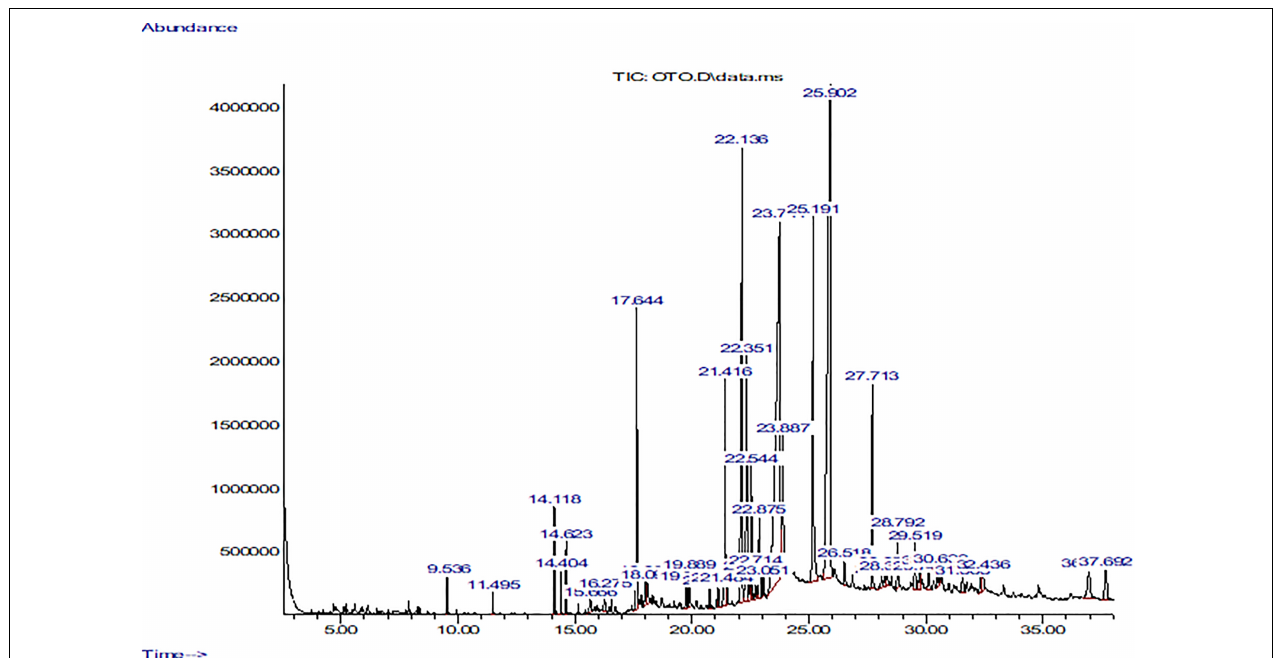
FIGURE 5 | GCMS chromatogram of methanolic extract of O. limbata